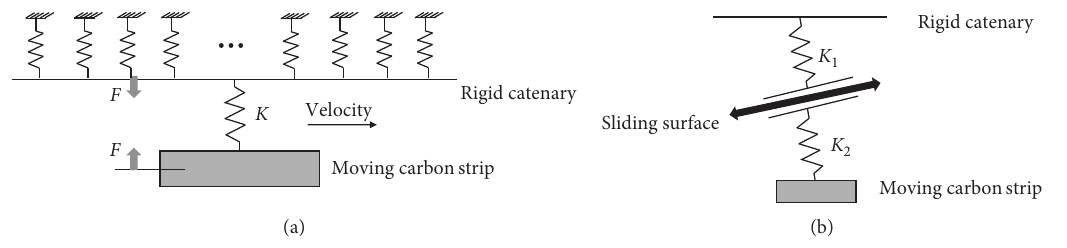
Figure 10: Interaction between carbon strip and catenary. (a) Vertical model. (b) Transverse